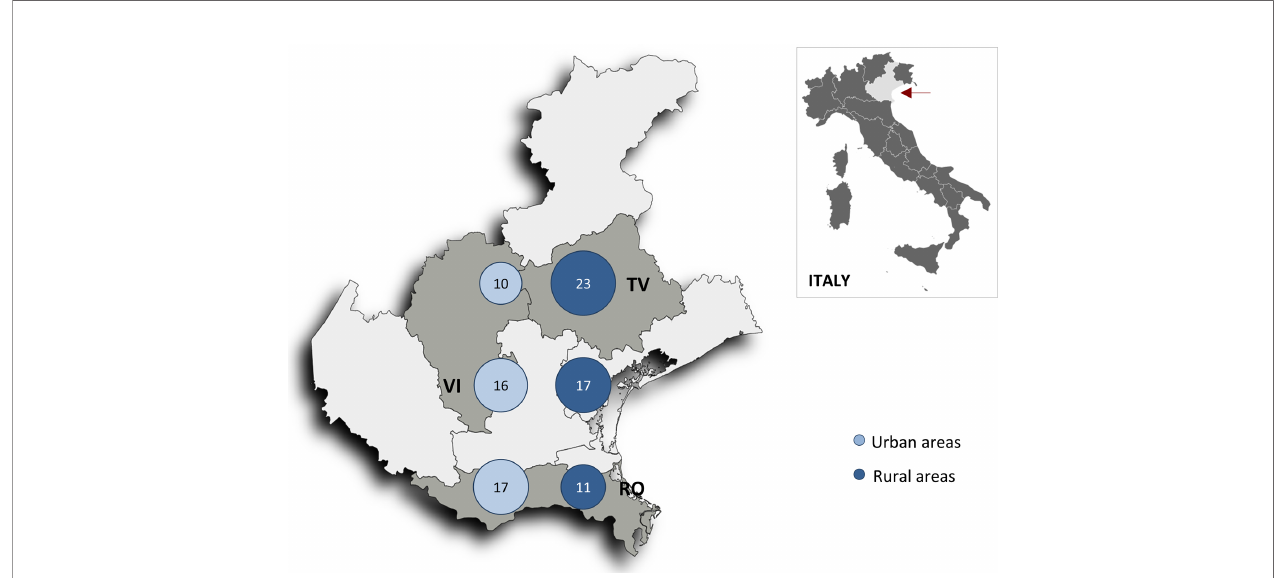
( Figure 3C ), and the fully adjusted ( Figure 3D ) Fine-Gray